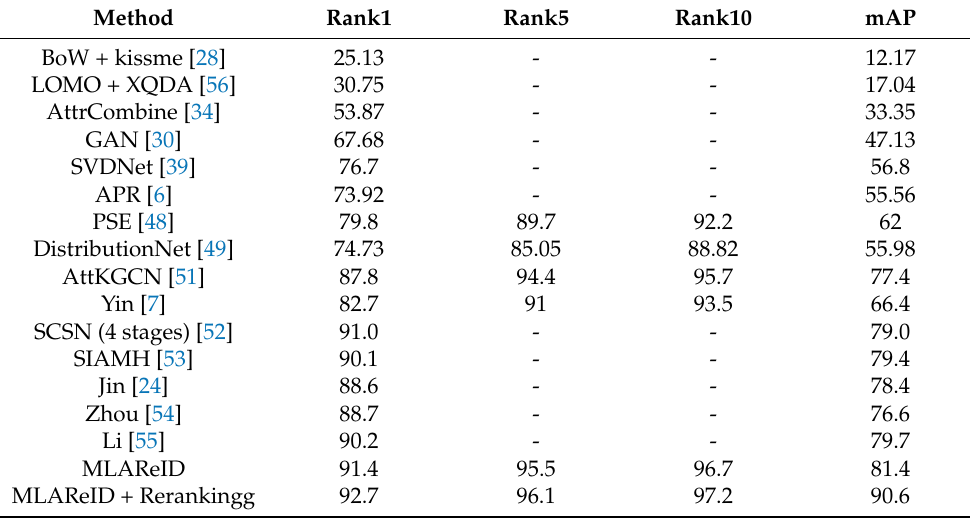
Table 2. Comparison with the state-of-the-art algorithms on